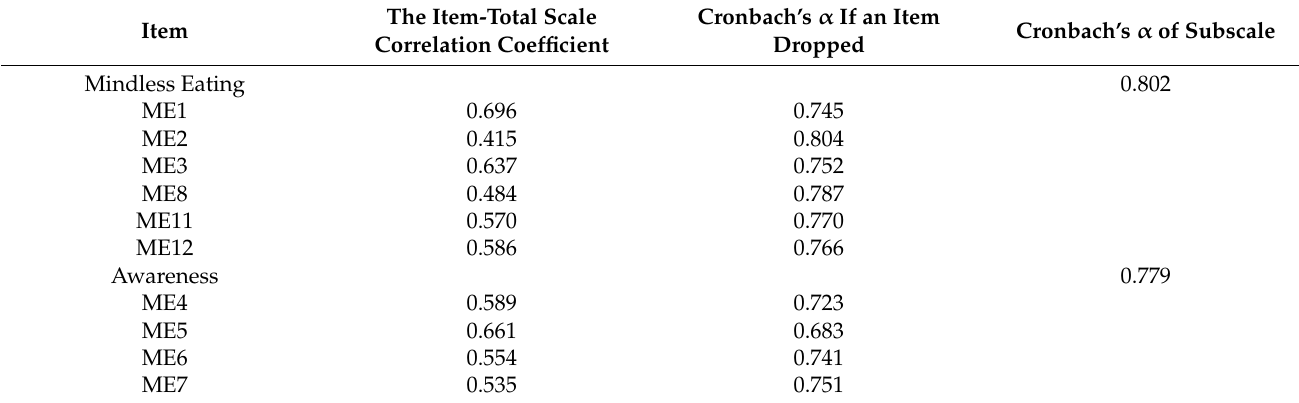
Table A3. Internal consistency reliability test.